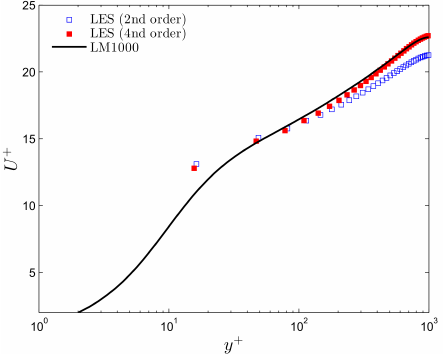
Figure 14. Mean streamwise velocity of turbulent channel flow by WMLES at Re τ = 1000.